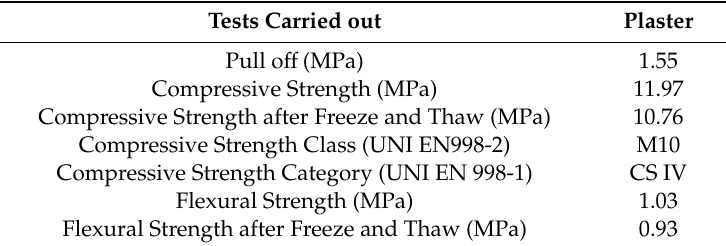
Table 8. Mechanical tests results performed on a plaster product.